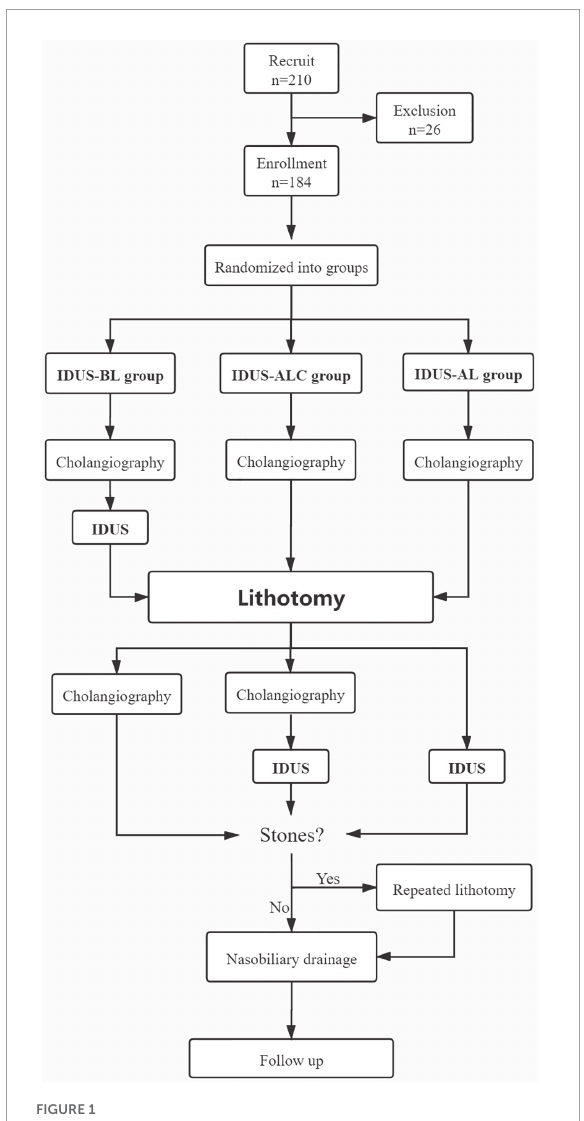
FIGURE1 Consort flow diagram of patients undergoing ERCP and